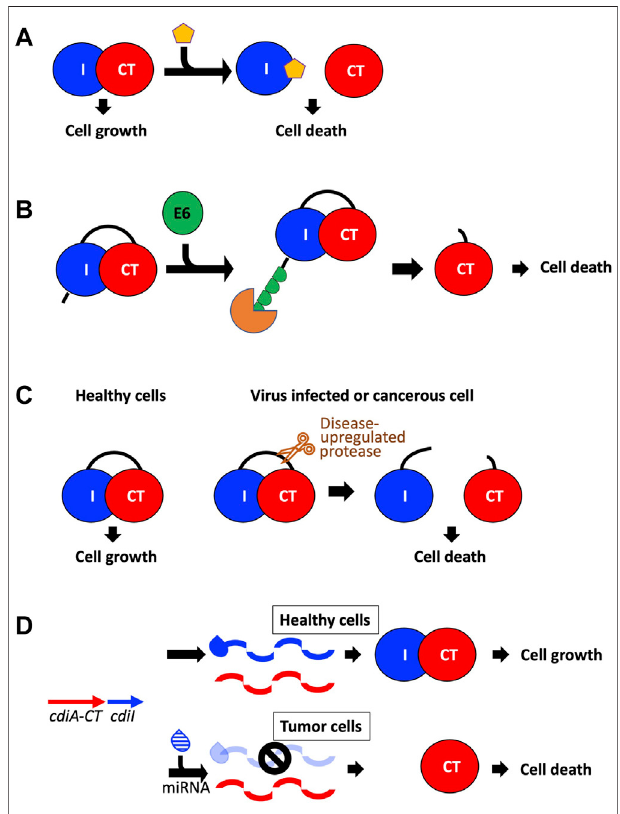
FIGURE 5 | Potential avenues toward utilizing CDI toxins to treat human disease. (A) The toxin/immunity complex can be disrupted by designing small moleculesthatbindtheimmunityproteinandfreethetoxintoinitiatecelldeath (Williams and Hergenrother, 2012; Unterholzner et al., 2013; Morse et al., 2015). (B) A fusion toxin/immunity protein is generated that encodes an onco-speci fi c POM (osPOM) at the immunity N-terminus that signals for oncoprotein E6 polyubiquitination in cervical cancer cells (Preston et al., 2016). Ubiquitination initiates the degradation of the immunity protein, freeing the toxin to initiate cell death. (C) Taking advantage of the upregulation of speci fi c proteases in cancer and virus-infected cells, a fusion toxin/immunity protein can be designed with a linker that is selectively cleaved by an upregulated protease (Chan et al., 2015; Yeo et al., 2016). Protease cleavage frees the toxin and results in cell death. (D) A DNA sequence complementary to an onco-miRNA isplaced upstream tothe immunitygene, and functions as an osPOM. When the toxin and immunity genes are transcribed, the oncomiRNA binds the complementary sequence and initiates degradation of the immunity mRNA. Thus, in cancer cells, transcription of the immunity gene is silenced while toxin transcription continues, leading to toxin-induced cell death (Turnbull et al., 2019; Houri et al.,